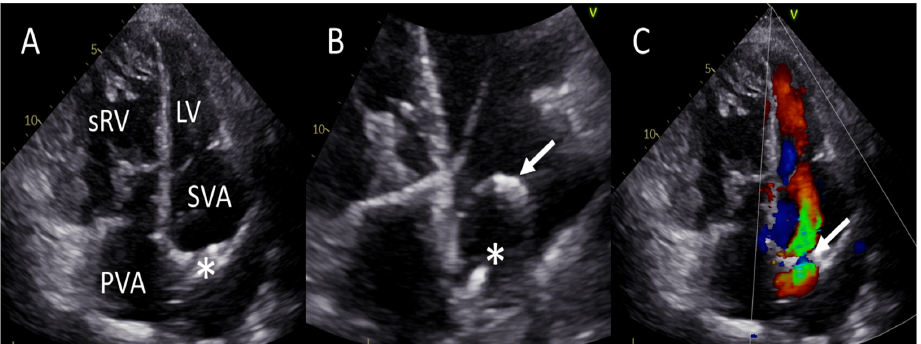
Figure 3. Baffle leak visualization in patient C. ( A ) Apical four chamber view shows the systemic venous return atrium (SVA), left ventricle (LV), the dilated and hypertrophied systemic right ventricle (sRV), and the pulmonary venous atrium (PVA). There is a suspicion of a baffle defect (asterisk (*) in A ). ( B ) A small mobile structure suspicious of a vegetation (asterisk (*) in B ) can be seen on the SVA side of the baffle defect. Note the atrial lead (arrow). ( C ) Color flow Doppler apical four chamber view demonstrates a PVA to SVA shunt over the baffle defect (arrow).